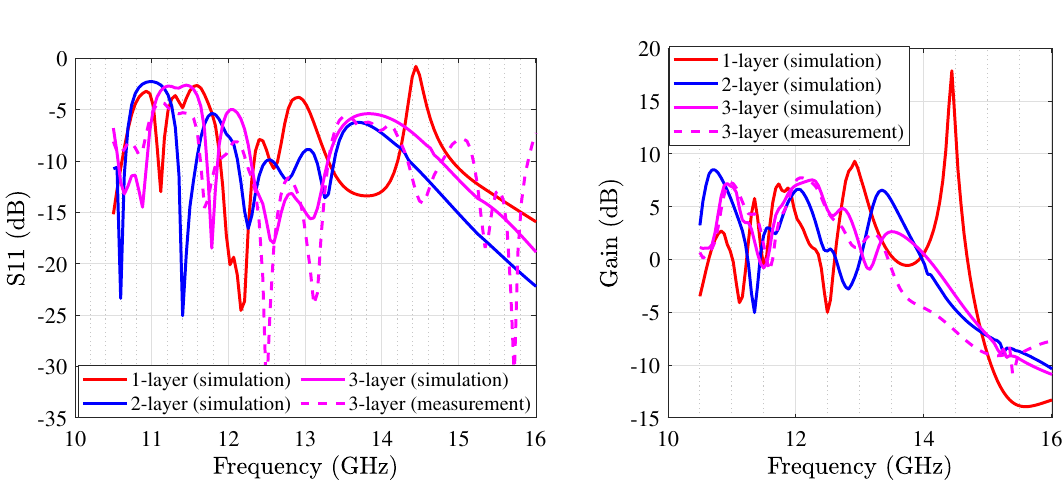
Figure 13. S 11 parameter of antenna-2 (left); gain of antenna-2